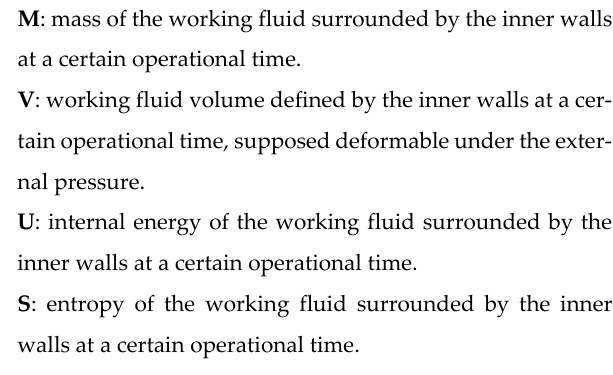
Figure 1. Basic irreversible thermal systems.